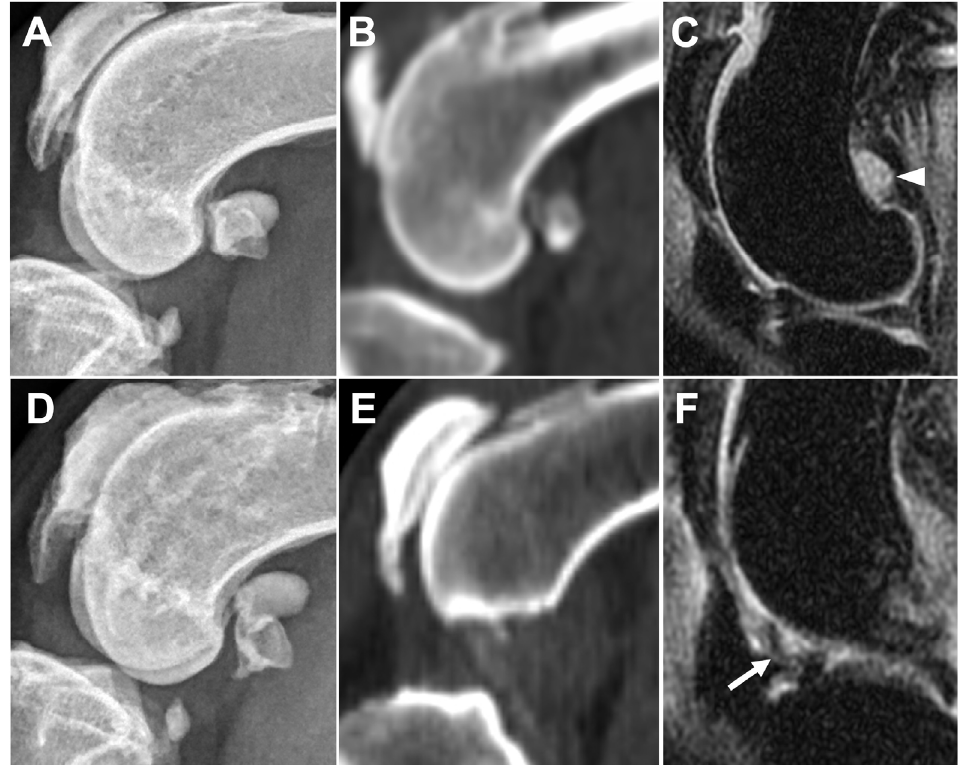
Figure 8. Comparison of medial fabella synovial effusion on DR ( A ), CT ( B ), and MRI ( C ), and infrapatellar synovial membrane thickening on DR ( D ), CT ( E ), and MRI ( F ) in the same leg. Obvious synovial effusion (arrowhead) is seen at the medial fabella region on MRI image ( C ) but cannot be observed on DR ( A ) or CT ( B ) images. Synovial membrane thickening is seen as low intense signal inside the synovial cavity (arrow) on MRI ( F ) but cannot be observed on DR ( D ) or CT ( E ) images.